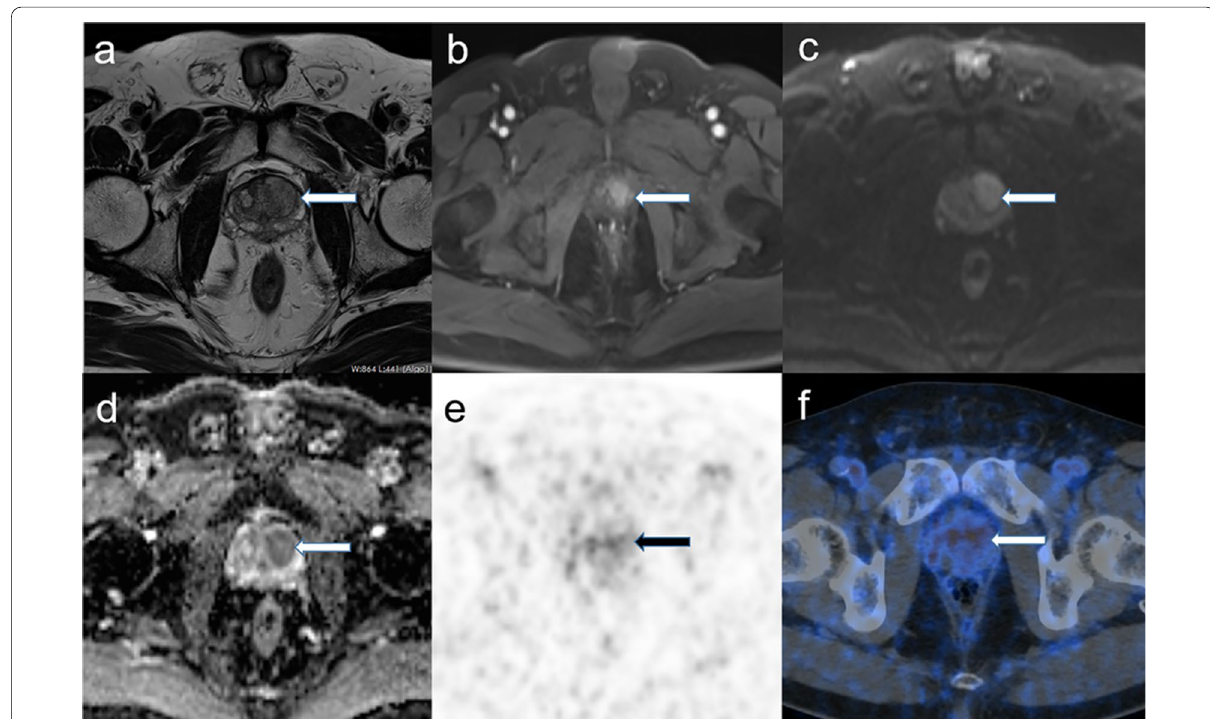
Fig. 3 Example of an inconsistent evaluation using mpMRI ( ) and 68 Ga-PSMA PET/CT ( ) in low- and intermediate-risk PCa. A 59-year-old patient + − whose serum PSA level was 8.0 ng/ml, and GS was 3 3. There is a lesion in the left transition zone of the prostate gland in the pelvic MRI scan ( a + T2w, arrow; b contrast-enhanced T1w sequence, arrow), and a diffusion restriction ( c b 1500 DWI, arrow; d corresponding ADC map, arrow) makes the presence of a large PCa very likely. In the 68 Ga-PSMA PET/CT there is no strong tracer uptake highly likely to not be diagnosed (arrow in e and f ). a – d MRI; e – f 68 Ga-PSMA PET/CT; a T2w; b : contrast-enhanced T1w; c b 1500 DWI; d ADC map; e maximum intensity projection of the PET; f fusion